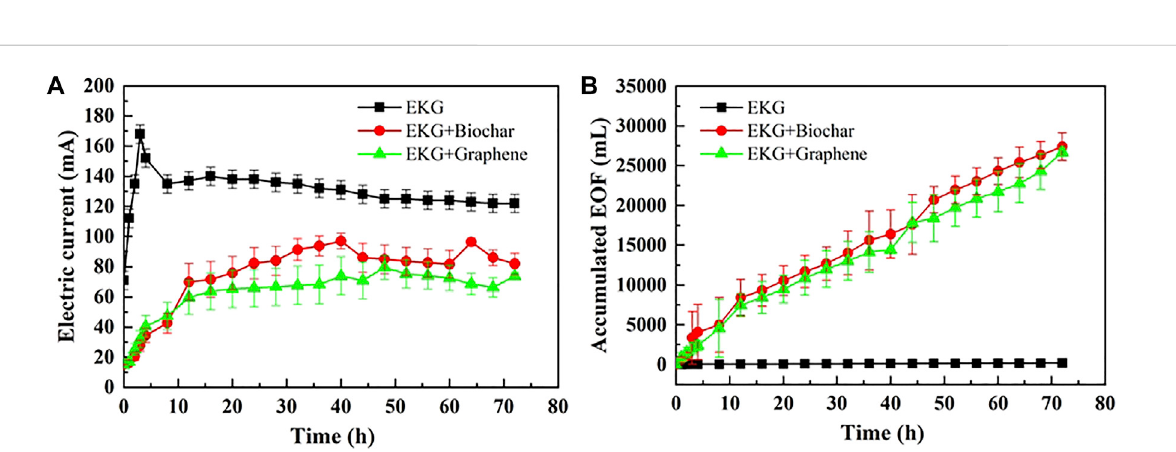
FIGURE 7 Variation of electric current and EOF versus time during the electrokinetic experiment subjected to the effect of the adsorbed material: (A) electric current and (B) accumulated